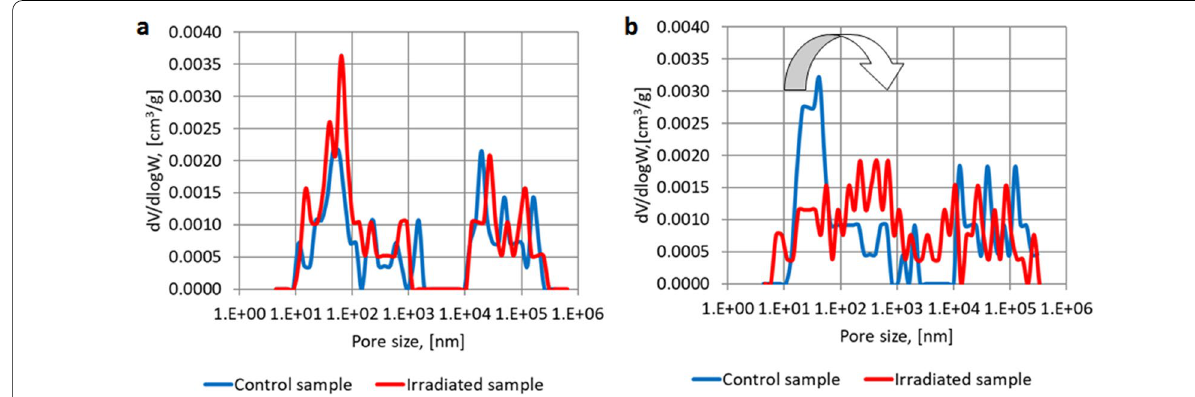
Fig. 12 Pore size distribution: a not loaded samples, b loaded samples.